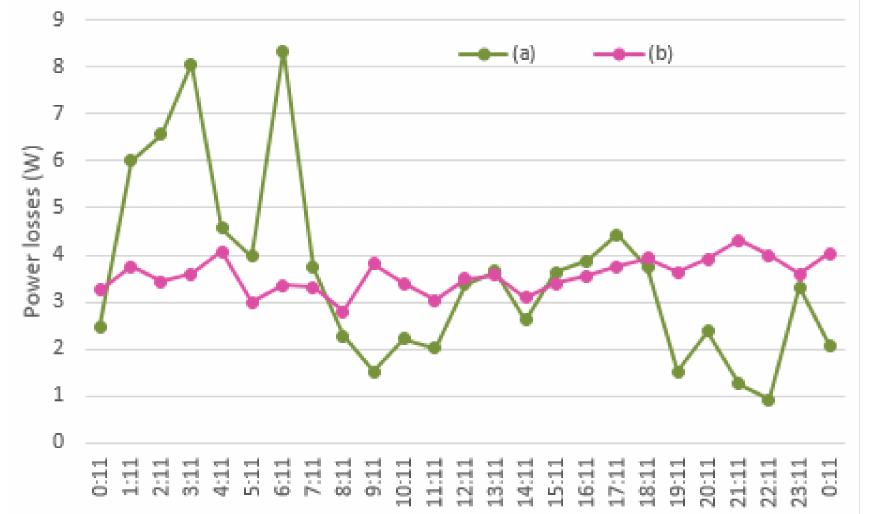
Figure 8. Transformer power losses in 24 h of a holiday caused by: ( a ) unbalanced currents ( P cu ) and ( b ) distorted currents ( P ch